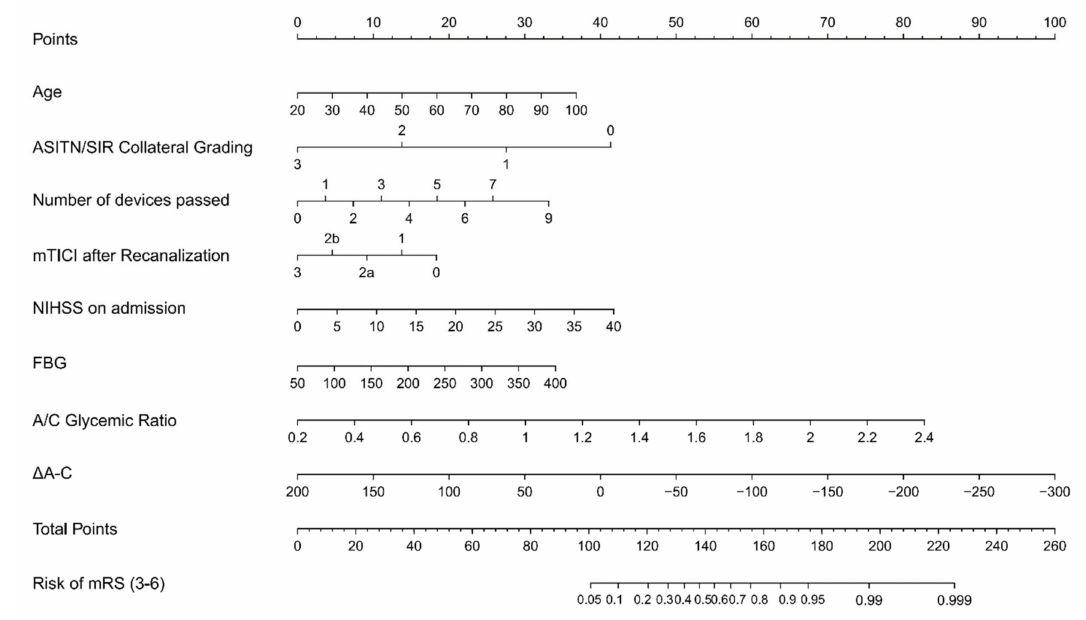
Figure 2. Nomogram for predicting the probability of three-month poor outcome in ischemic stroke patients receiving EVT. We drew a line perpendicular to the point scale axis and added the points for all variables. Then, we could estimate the risk of poor outcome through the total points. ASITN/SIR, American Society of Interventional and Therapeutic Neuroradiology/Society of Interventional Radi- ology; mTICI, Modified Thrombolysis in Cerebral Infarction; NIHSS, National Institutes of Health Stroke Scale; FBG, fasting blood glucose; A/C, FBG/chronic; ∆ A-C , the difference between FBG and chronic glycemia; mRS, modified Rankin Scale.